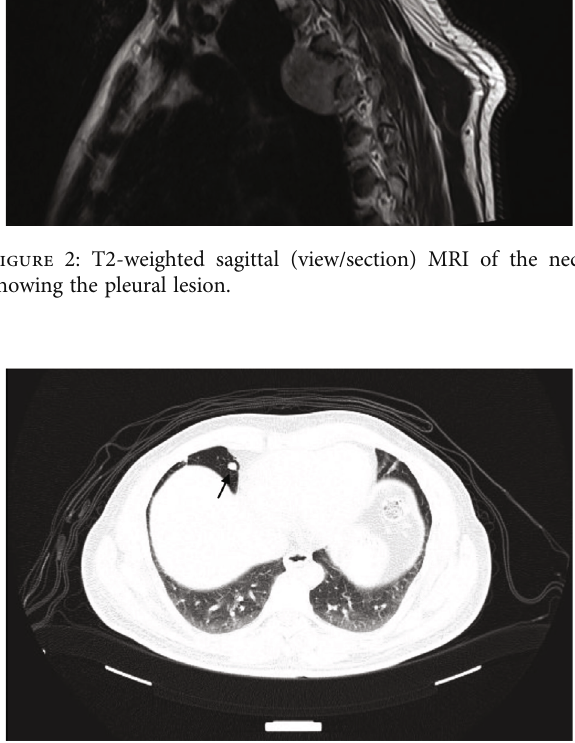
Figure 3: High-resolution chest CT shows a pulmonary nodule in the right middle lung lobe denoting pulmonary metastasis.